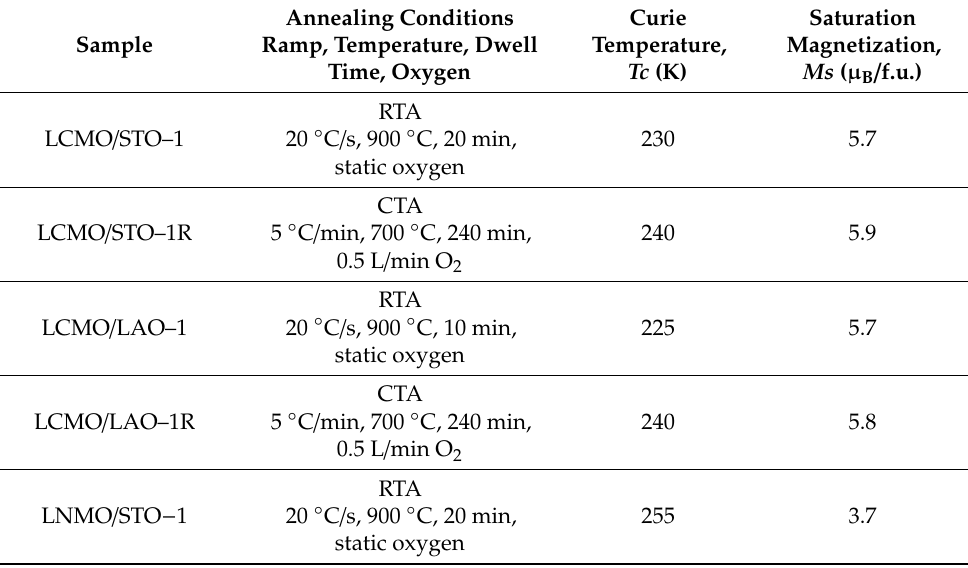
Table 1. List of samples whose magnetic properties have been analyzed, with the corresponding RTA growth conditions and the parameters of the subsequent CTA treatment. The extracted values for Tc and Ms are also